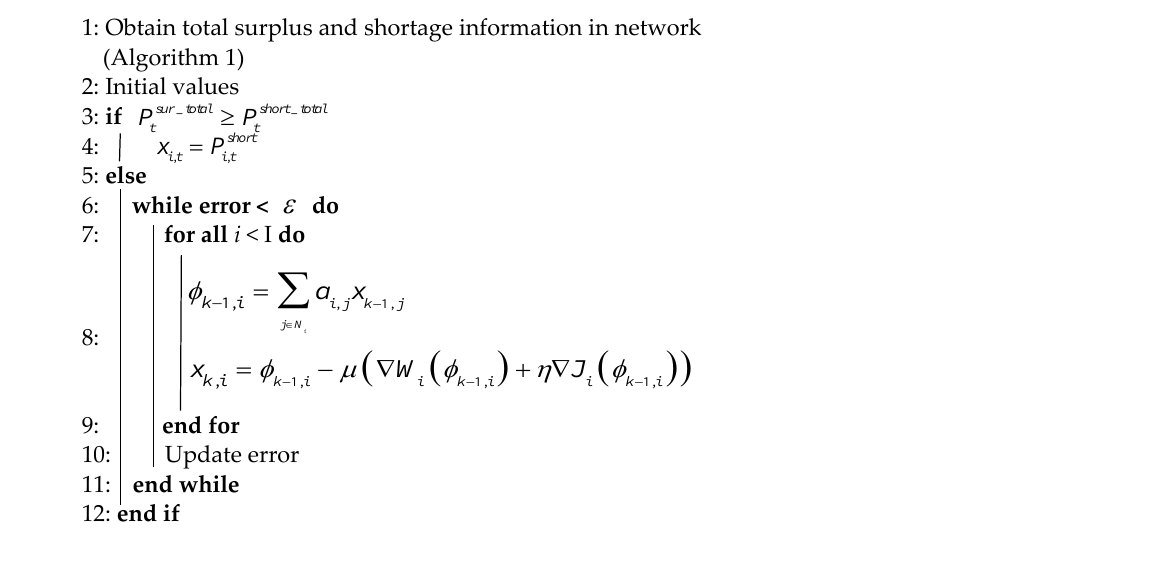
Algorithm 2: Distributed demand